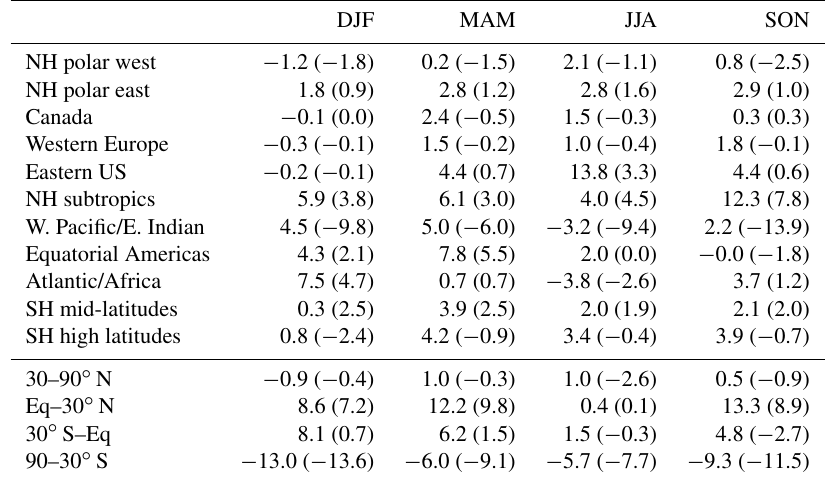
Table 7. The reanalysis ozone concentration differences between the ozonesonde sampling (for both time and space using 2-hourly reanalysis fields) and the complete sampling at 500hPa (in % relative to the complete sampling). Results using monthly reanalysis fields sampled at the ozonesonde locations are also shown in brackets.